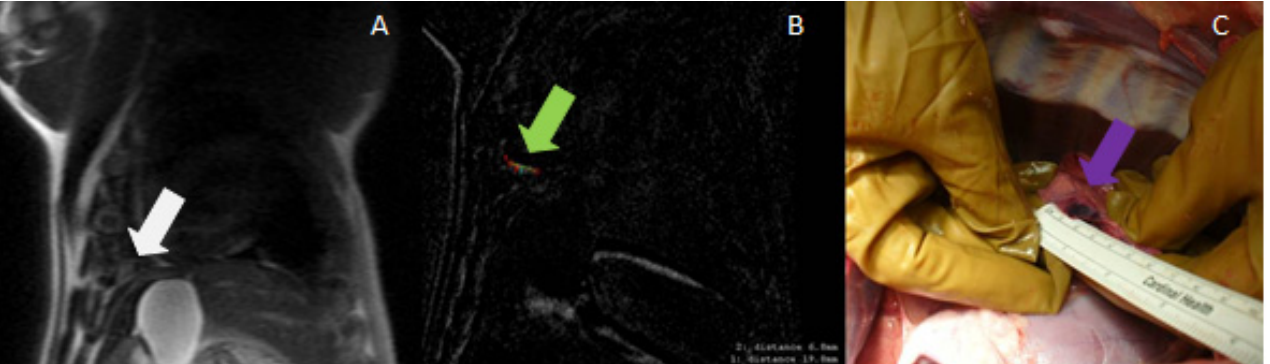
Figure 7. ( A ) MRI (localizer) used for treatment planning in the pleura (white arrow); ( B ) Post-ablation MRI (subtraction of LAVA pulse sequence images before and after ablation), showing a very small ablated area near the diaphragm (green arrow); ( C ) necropsy image showing the ablated area in the pleura (purple arrow).